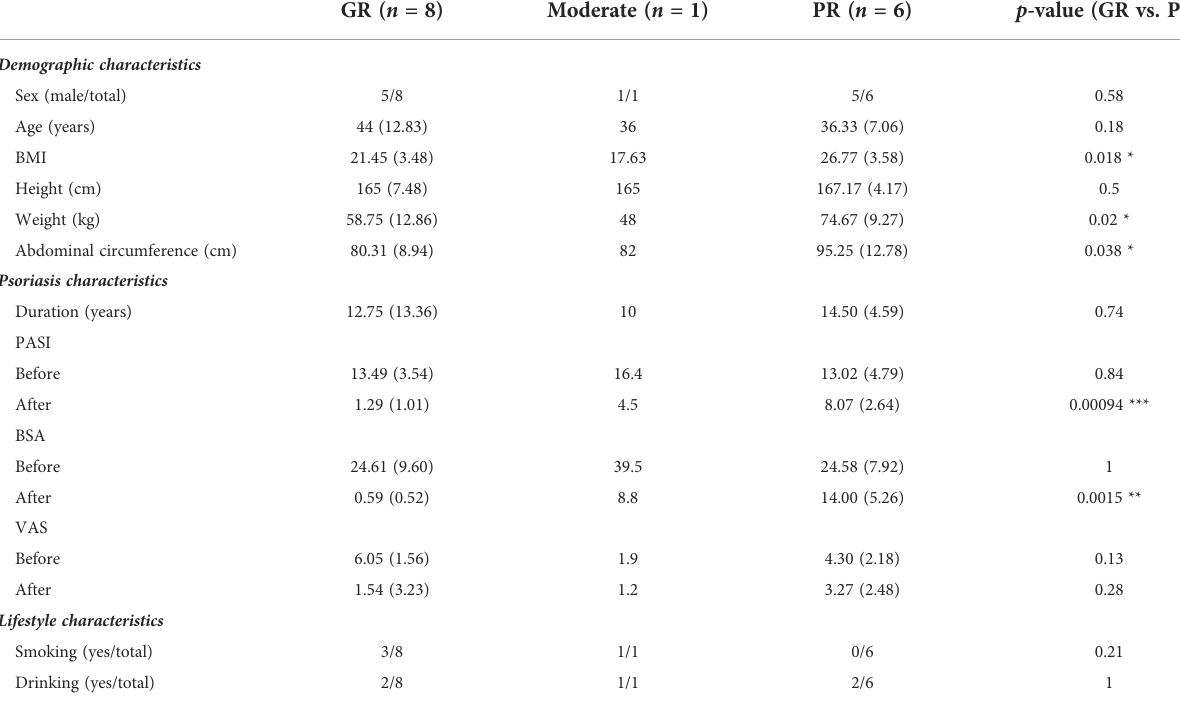
TABLE 1 Summary of patient demographic and clinical